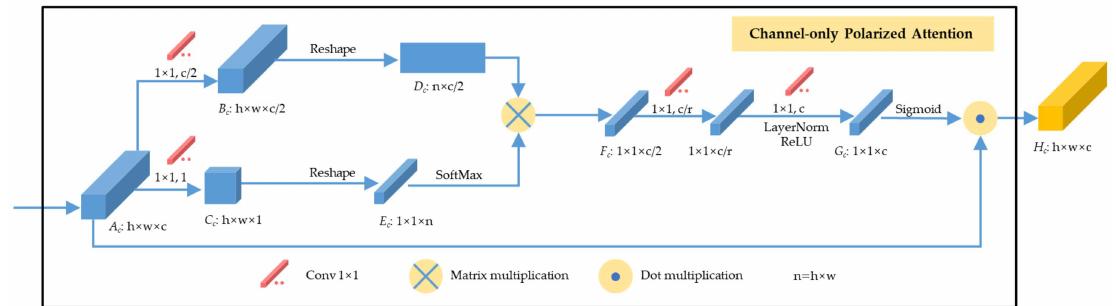
Figure 4. Details of the channel-only polarized attention mechanism in our